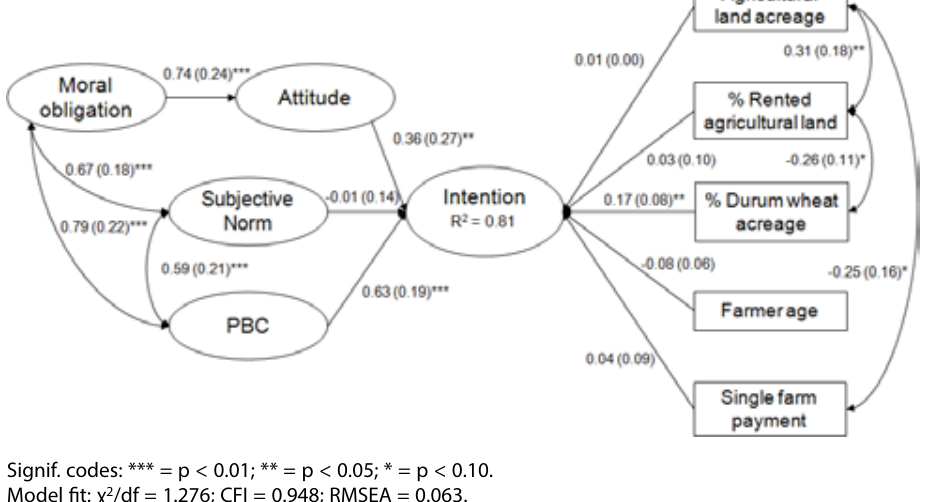
Figure 3. Structural equation model results, behaviour 2 “Sustainability scheme”: R-squared, standard- ised coefficients, correlations and standard errors (in